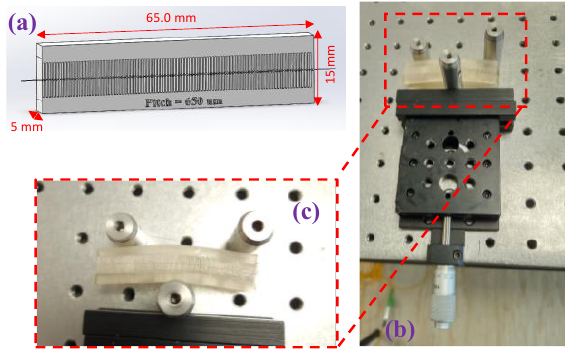
Fig. 1 . (a) CAD image of the grooved plate. (b) Experimental setup for the curvature test. (c) Inset of the sensor under curvature.